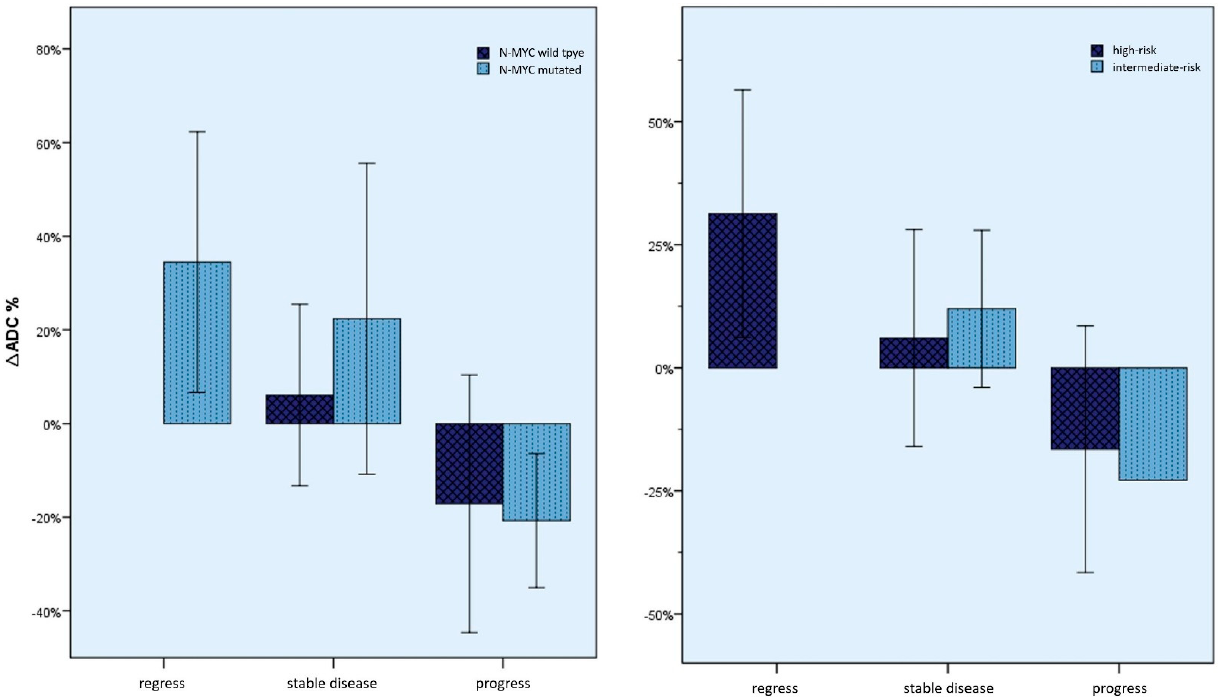
Figure 8. Mean percentage ∆ ADC values (whiskers = 1 SD) by N-Myc status and by INRG risk groups. Significant differences could not be seen here between the changes depending on the N-Myc status or the INRG risk group.